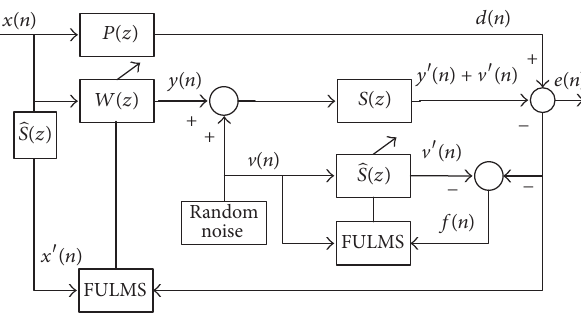
Figure 3: FULMS algorithm with online